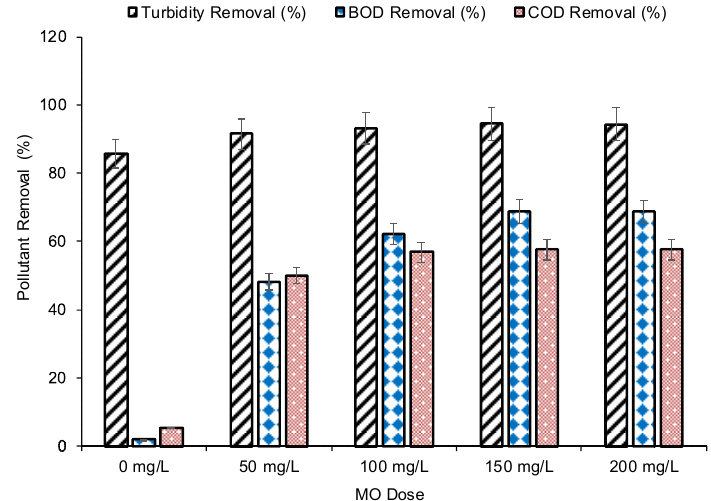
Figure 1. E ff ect of MO biomass coagulant dosage on turbidity, BOD, COD removal of Figure 1. Effect of MO biomass coagulant dosage on turbidity, BOD, COD removal of municipal municipal wastewater.